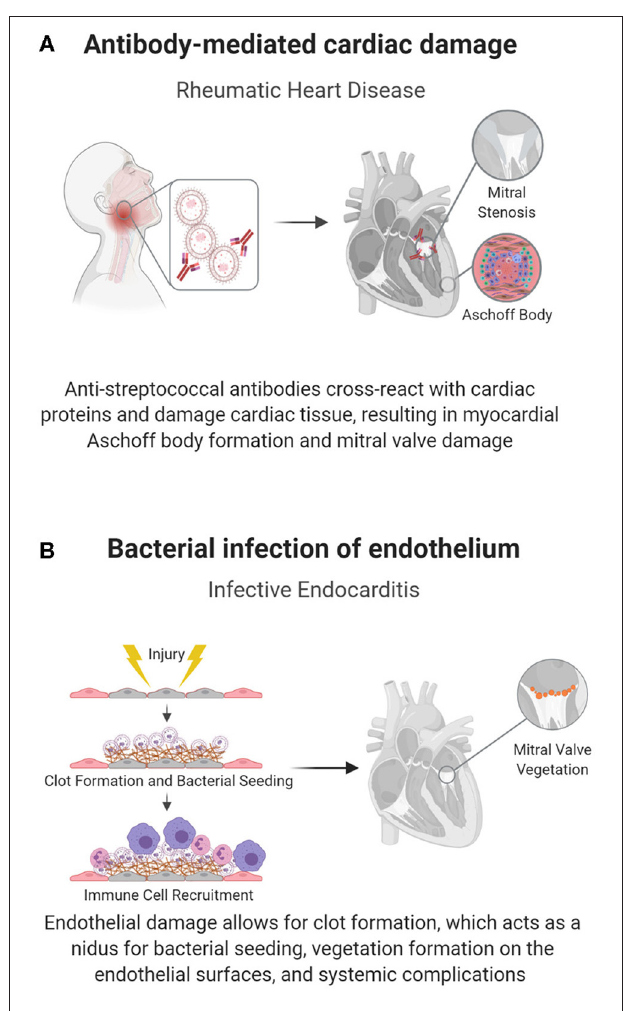
FIGURE 2 | Pathogen-induced acquired pediatric heart disease. Some pediatric cardiac conditions have well-defined immune causes in response to an infectious organism. (A) In RHD, biomimicry, in which antibodies against Group A streptococcal bacteria cross react with cardiac proteins, causes cardiac damage, specifically mitral valve fibrosis and subsequent stenosis. (B) The endothelium can also become directly infected, as seen in endocarditis, in which flow induced damage creates a nidus for bacterial